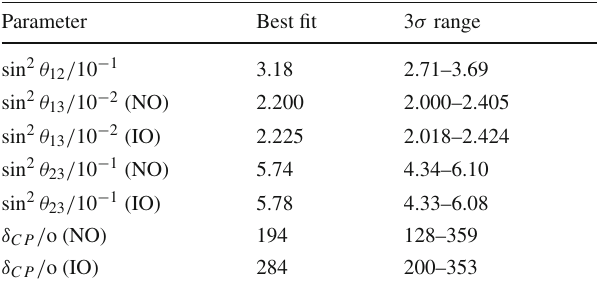
Table 1 Best fit and 3 σ ranges for the neutrino mixing angles and CP violatingDiracphase,whichareobtainedfromtheglobalfitstoneutrino oscillation data